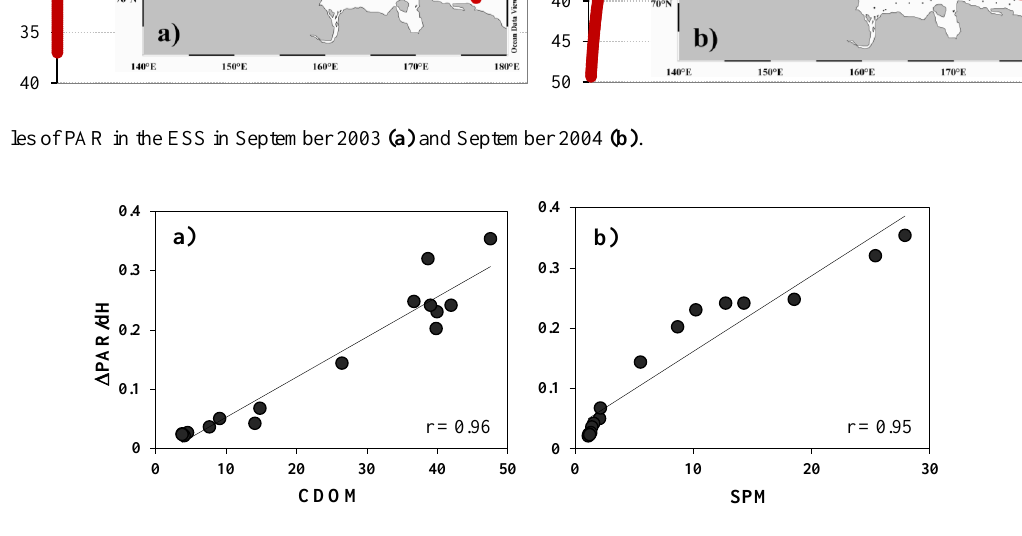
Fig. 13. Correlation of the PAR extinction versus CDOM (µgl − 1 ) (a) and SPM (mgl − 1 ) (b) in the H 1 layer.